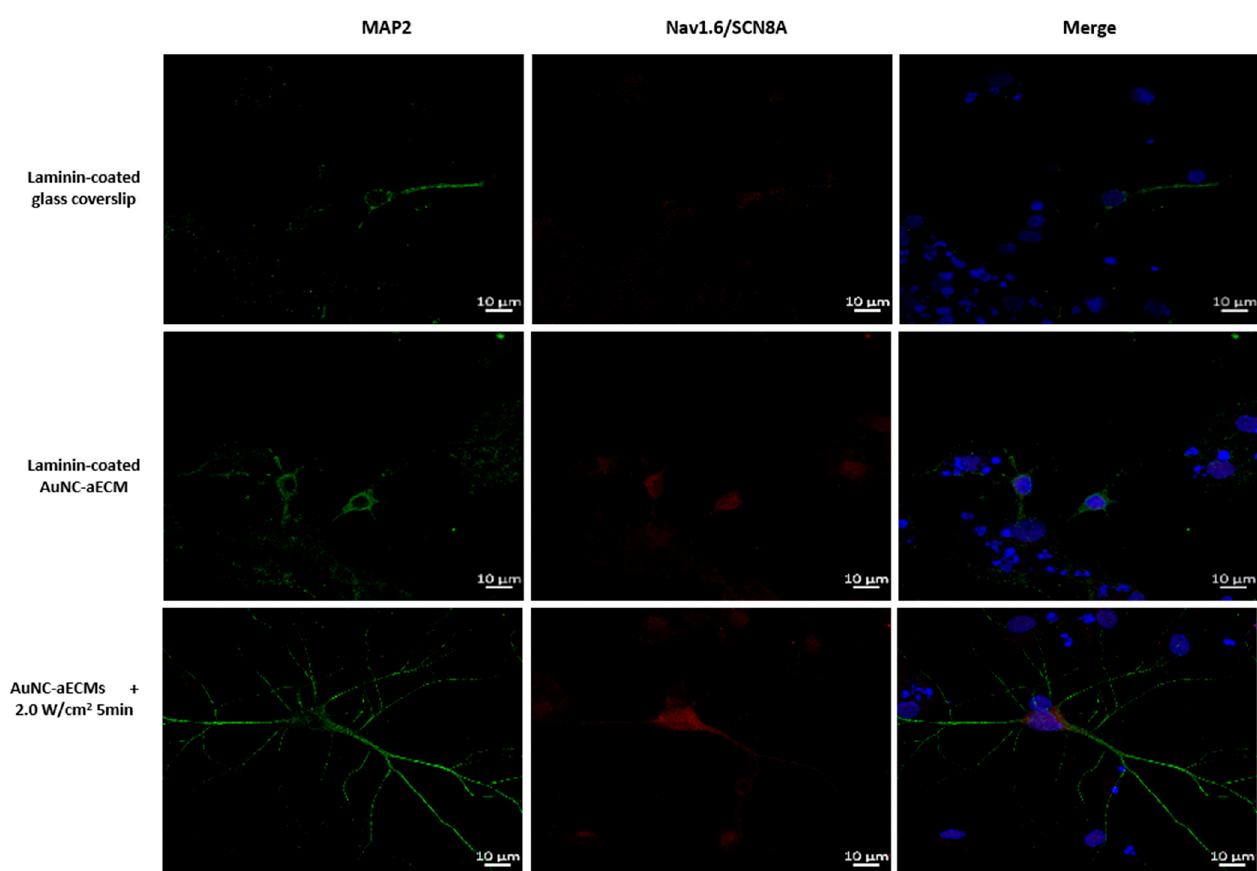
Figure 6. Immunofluorescence double staining of MAP2 and Na+ channels in differentiated neurons grown on laminin- coated AuNC-aECMs with/without laser irradiation. rNSCs were seeded onto both laminin-coated glass coverslips and laminin-coated AuNC-aECMs. After 2 days, the cells growing on laminin-coated AuNC-aECMs were treated with the laser irradiation parameter (2.0 W/cm 2 for 5 min). After 14 days, cells were analyzed with immunostaining assay. Differentiated mature neurons and Na+ channels were identified with MAP2 (mature neuron marker) and Nav1.6 (Na+ channel marker), respectively.